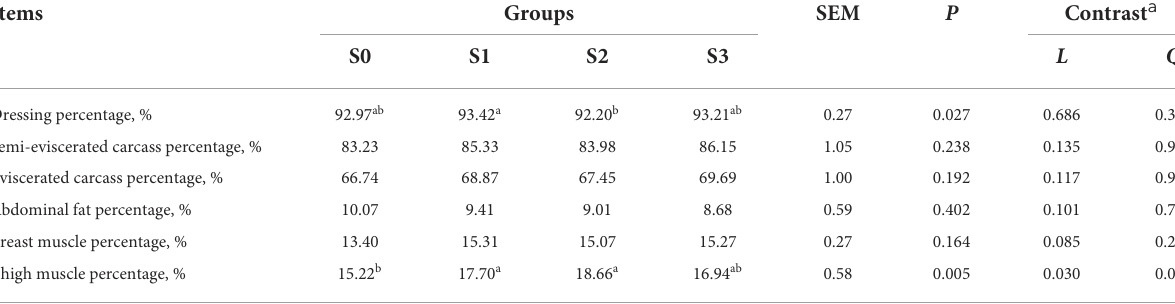
TABLE 3 Effects of diets supplemented with BMFA on slaughter performance of broilers.